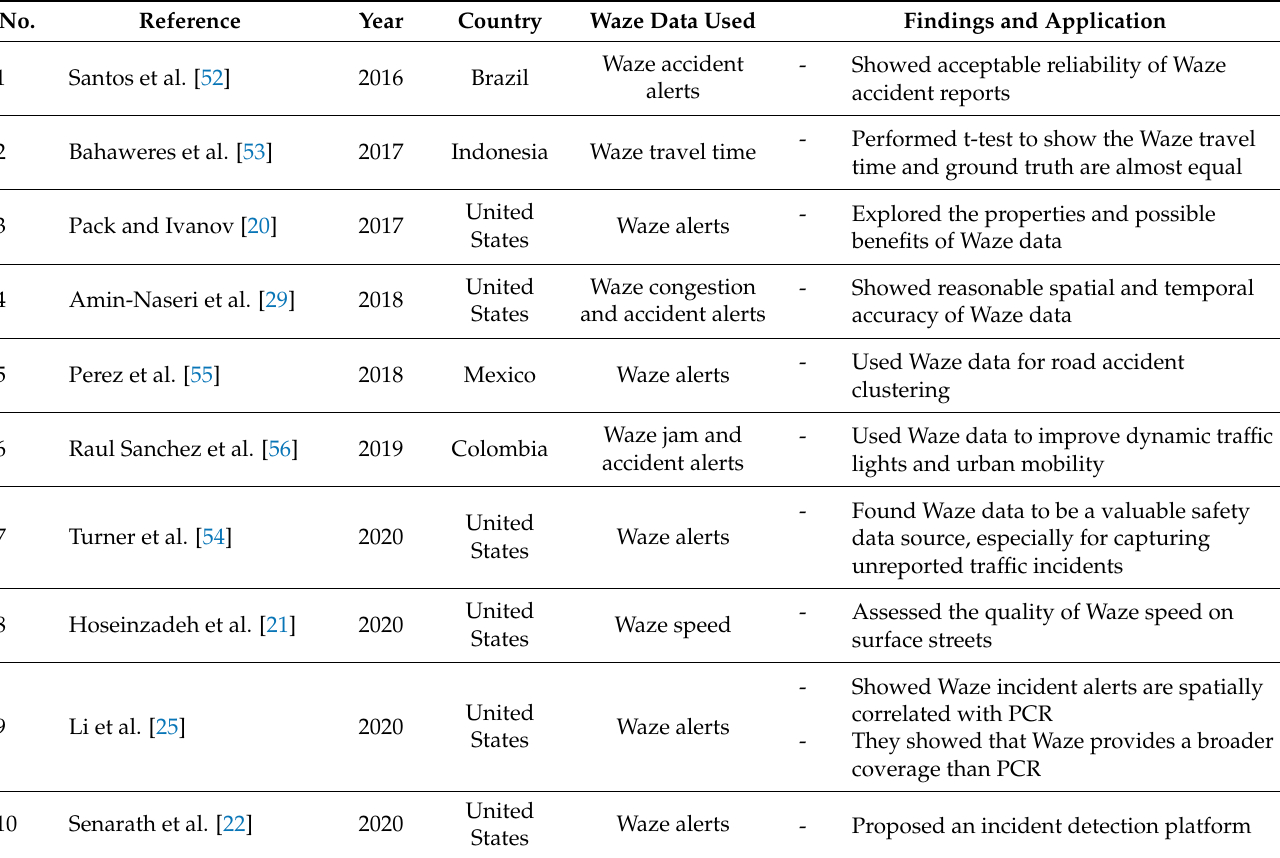
Table 2. Summary of studies using Waze data in the